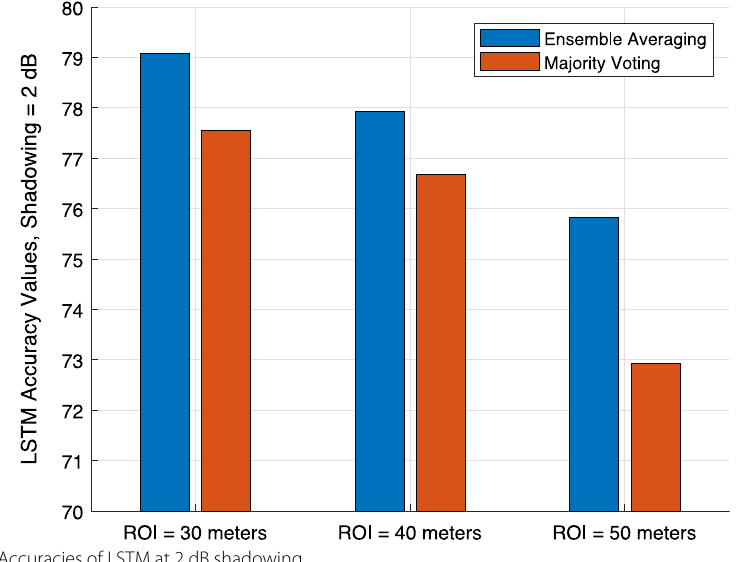
Fig. 7 Accuracies of LSTM at 2 dB shadowing